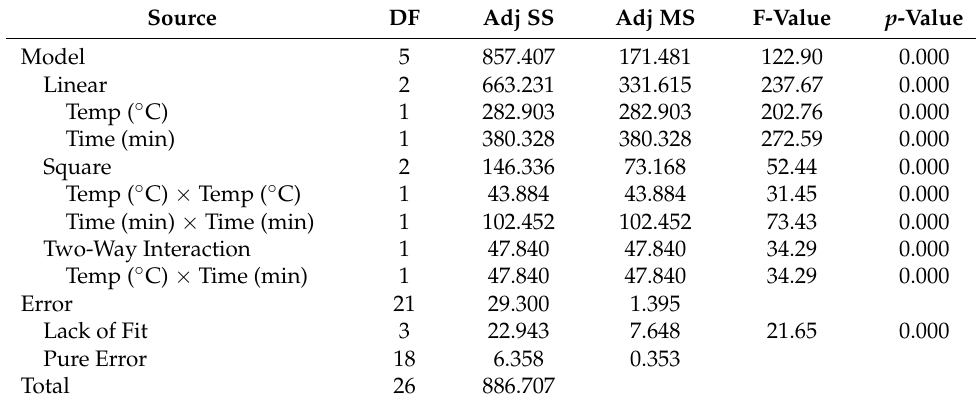
Table 5. Analysis of variance for hemicellulose content.